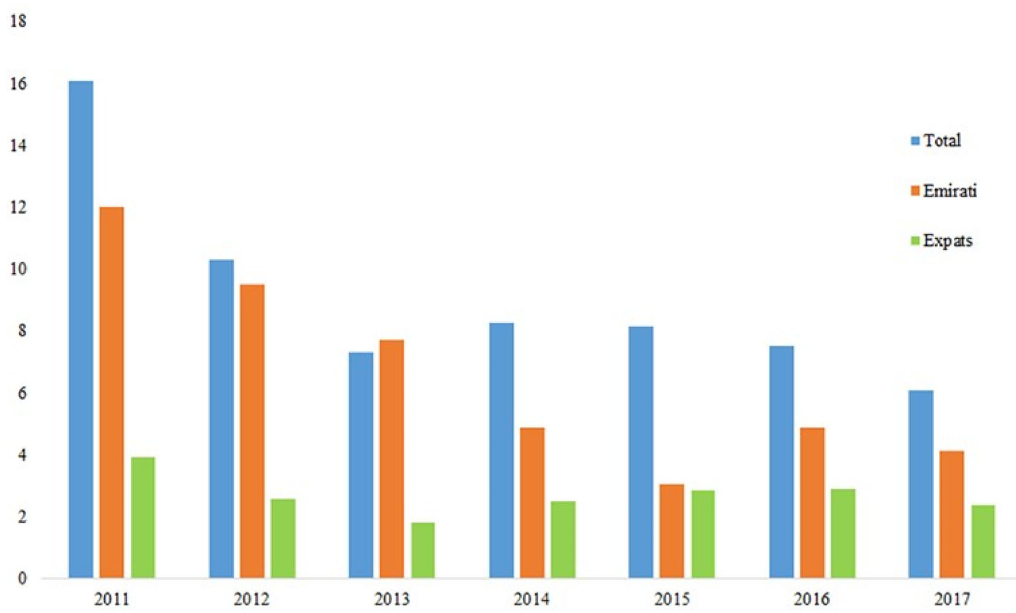
Figure 5. Female to male thyroid cancer incidence ratio per nationality within the